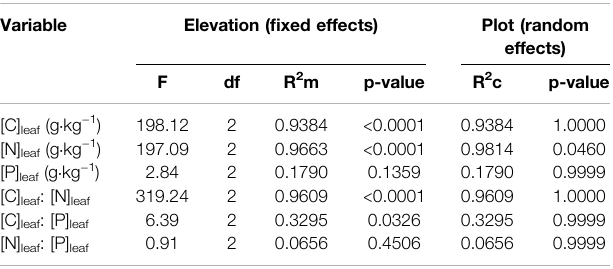
TABLE 2 | Linear mixed model results of the effects of elevation and plot on leaf ecological stoichiometry of L. virgaurea .